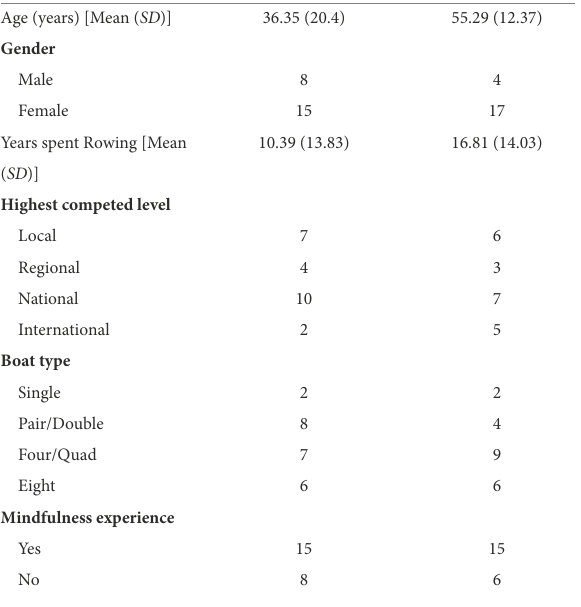
TABLE 1 Demographic